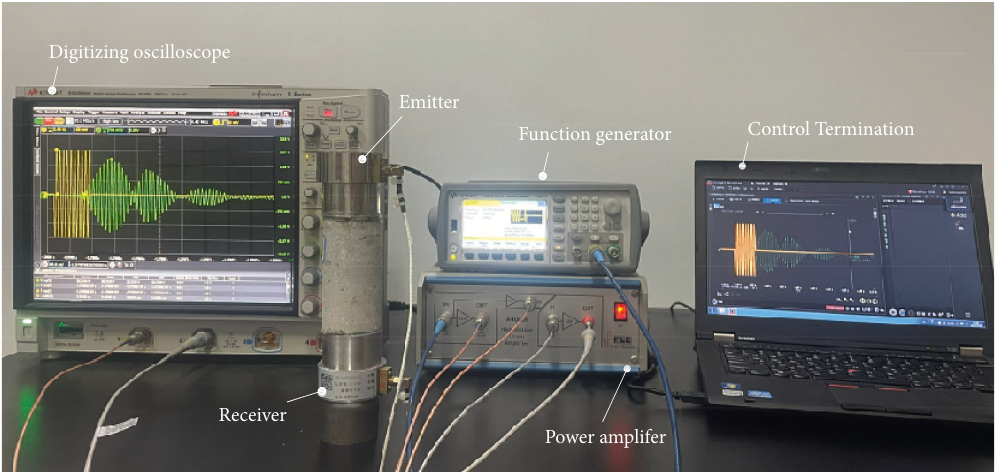
Figure 4: Diagram of ultrasonic testing